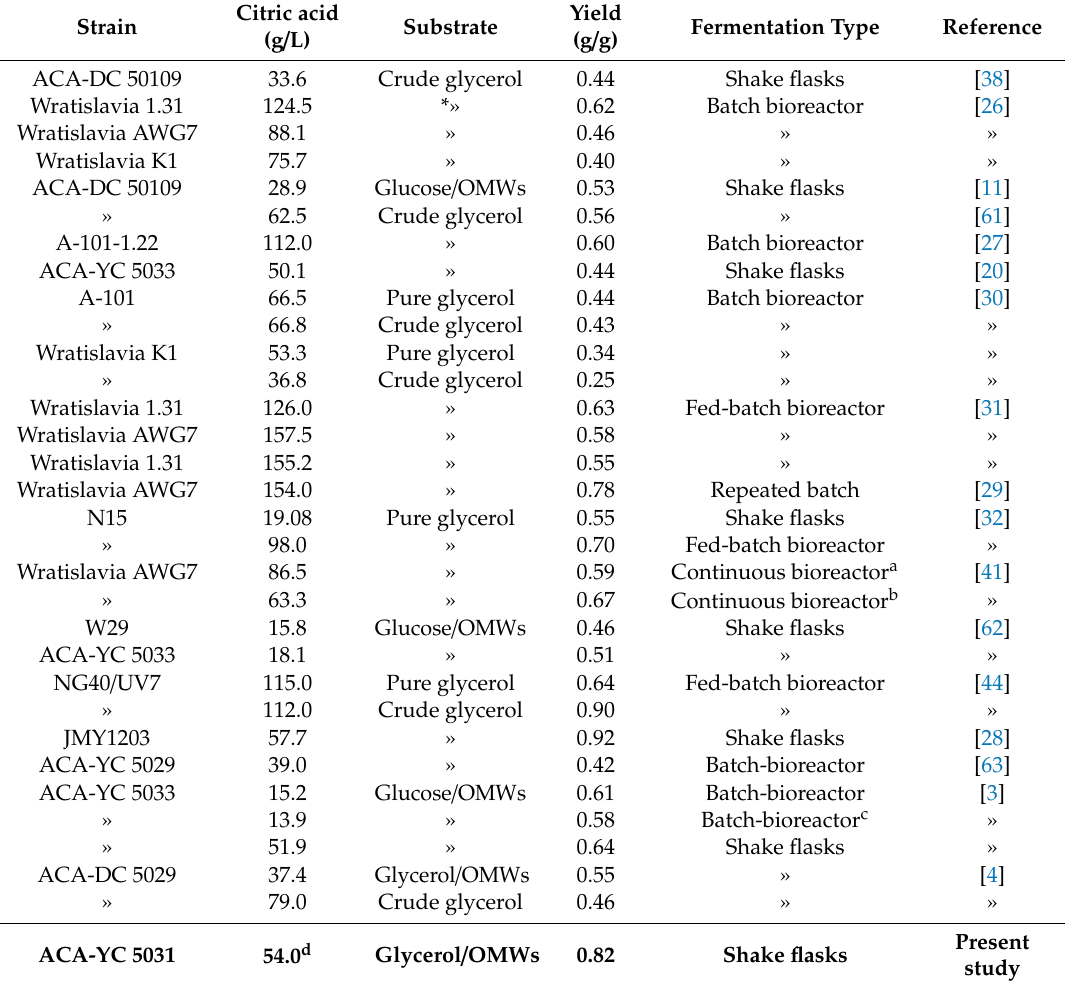
Table 4. Metrics of citric acid production from glycerol- or OMW-based media by Yarrowia lipolytica strains cultivated on various fermentation